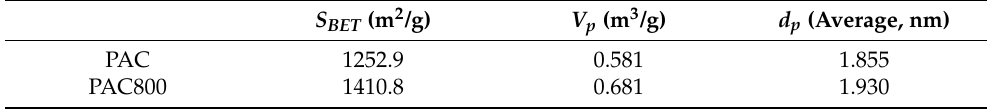
Table 1. Results of N 2 adsorption/desorption